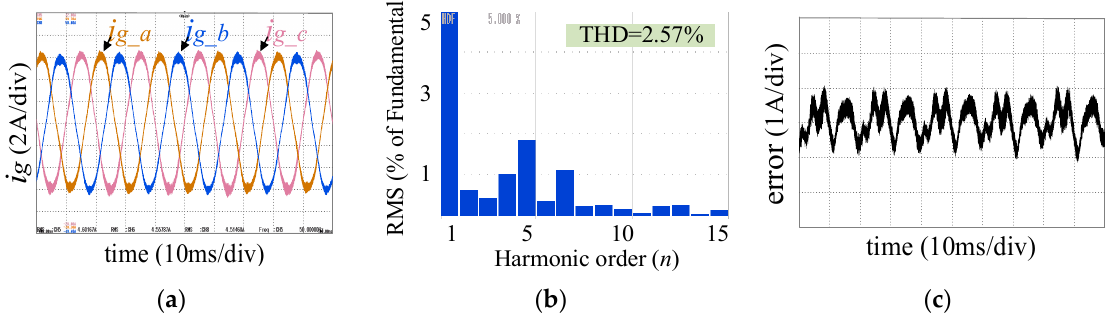
Figure 25. Experimental results of Newton ‐ FOPRRC with variable grid frequency. ( a ) Grid current i g . ( b ) Harmonic spec ‐ trum of i g_c . ( c ) Current tracking error ɛ .